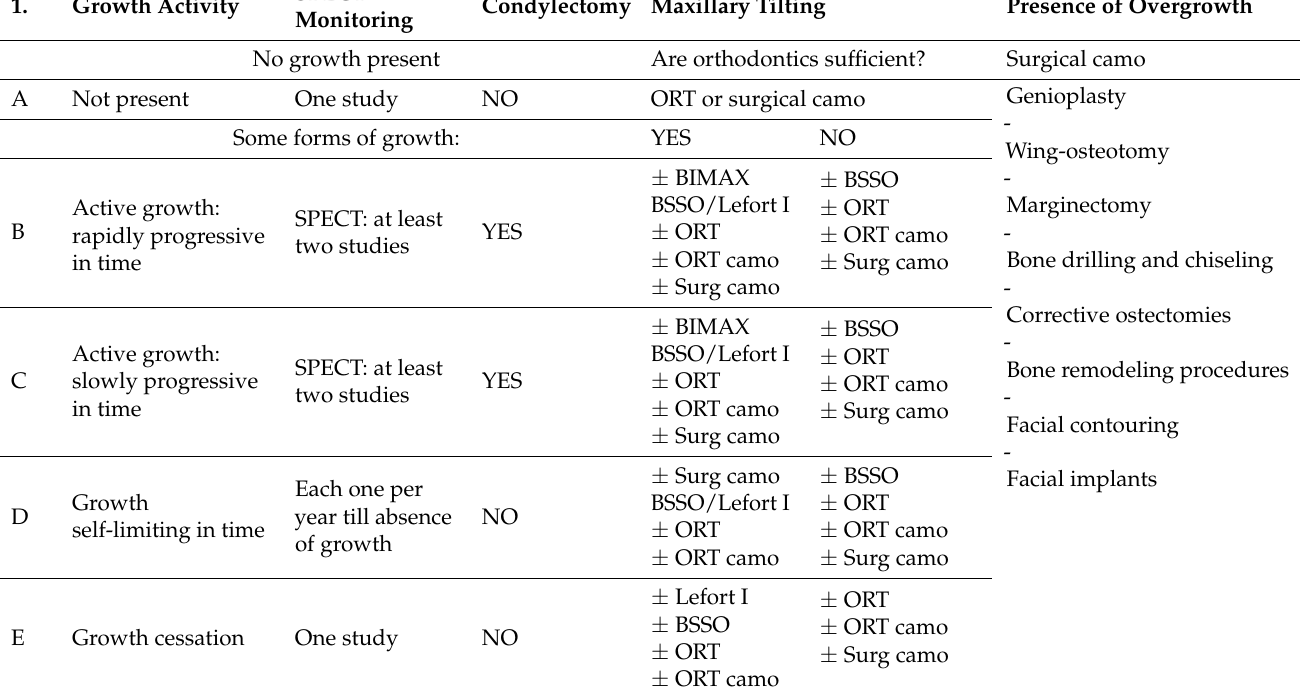
Table 1. Authors’ proposal on the scope of approaches. Each of the presented cases should be sched- uled for orthodontic treatment because of various scopes of dentoalveolar discrepancies. (1) Case A: asymmetry (MA) without pathological growth and no UCH symptoms: scheduled for orthodontic or surgical camouflage or solely bone remodeling if no dentoalveolar discrepancies are present. (2) Case B–C: rapid or slowly progressive in time FA with MA asymmetry and pathological growth still present in the affected condyle confirmed in SPECT and during clinical examination: mandatory condylectomy followed by orthodontic treatment. After 3–6 months the scope of asymmetry, degree of maxillary tilting, and patient’s willingness to undergo total symmetry correction decide the final approaches. If the scope of mandibular overgrowth is extensive some surgical camouflage or bone remodeling procedures can be chosen. (3) Case D: low growth in SPECT with a tendency to decrease in time: early orthodontics followed by patient monitoring. If the orthodontics is sufficient, then the treatment is finalized. On the other hand, when growth has caused asymmetrical bone discrepancies and orthodontics alone is not sufficient a decision on either BSSO/Lefort I or surgical camouflage could be used. (4) Case E: growth became limited over time: orthodontics is sufficient to prevent MA and FA. In some difficult cases, either BIMAX, BSSO, Lefort I, or another approach can be scheduled based on each individual case. Abbreviations: BIMAX—includes BSSO and Lefort I procedures performed simultanously; ORT—orthodontic